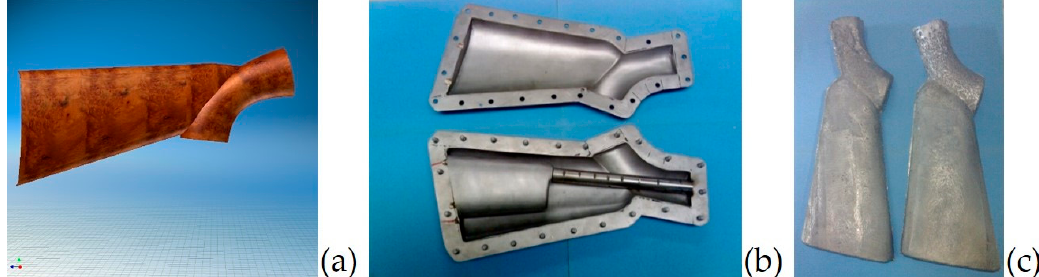
Figure 7. 3D model of the complex foam prototype designed in SolidWorks software ( a ). Stainless steel closed-mold ( b ). Complex foam parts (approx. 290 mm in height) ( c ).